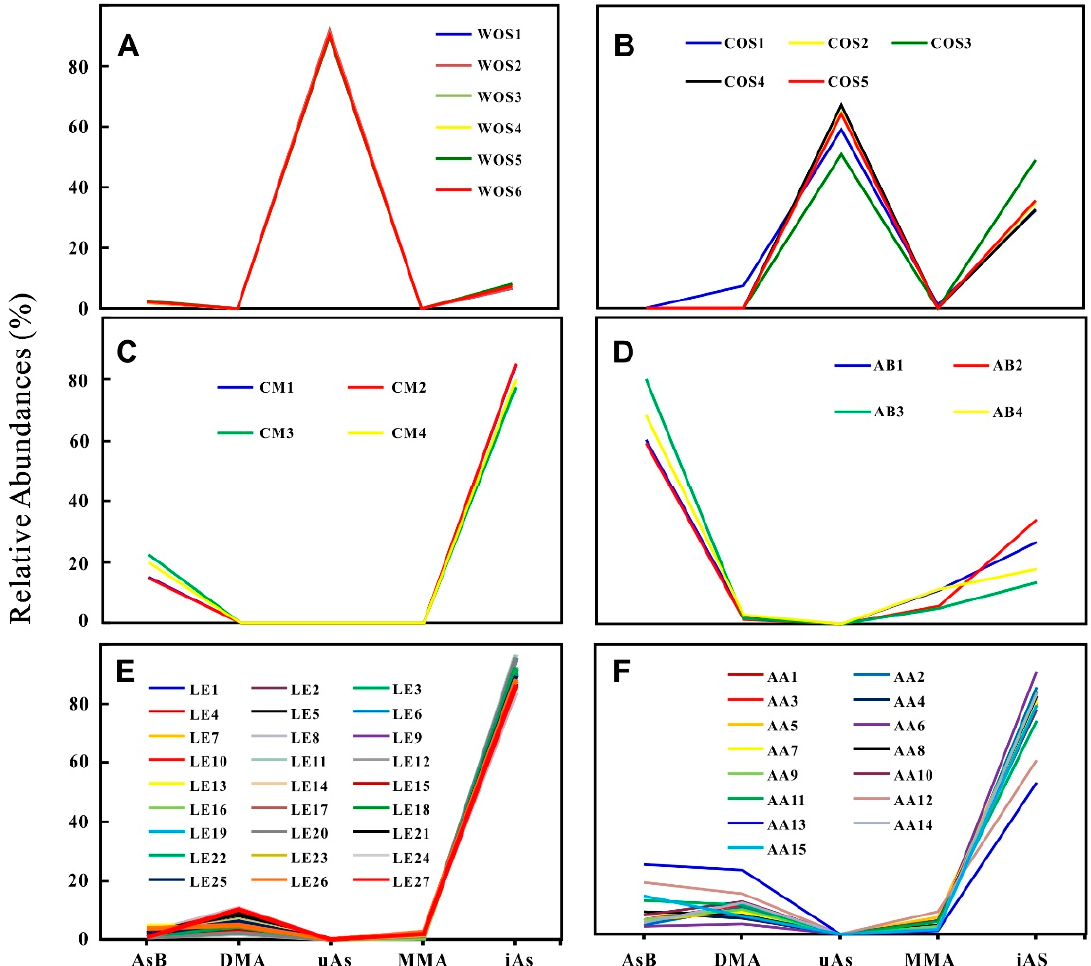
Figure 4. Variation of the relative abundances (%) of As species in wild Ophiocordyceps sinensis ( A ), cultivated Ophiocordyceps sinensis ( B ), Cordyceps militaris ( C ), Agaricus blazei ( D ), Lentinus edodes ( E ), and Auricularia auricula ( F ).